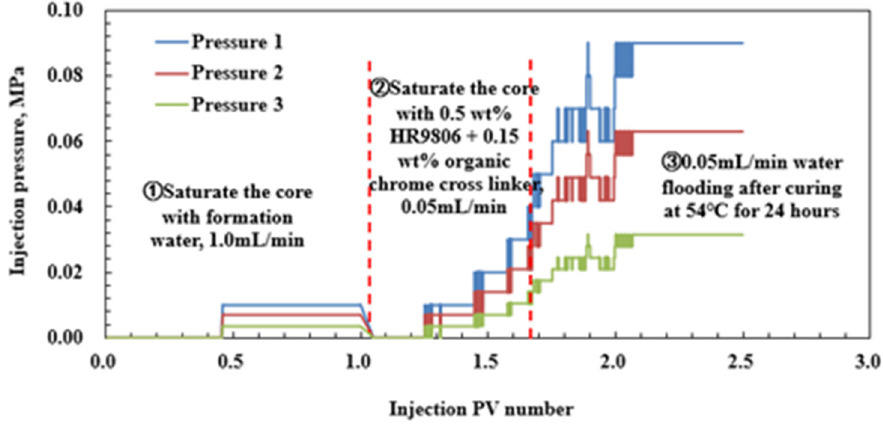
Figure 13. Plugging experimental pressure curve of weak gel system in porous media.